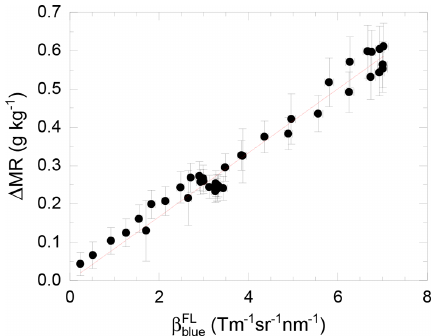
Figure 10. Relation between the magnitude of the water vapor mix- ing ratio correction ( (cid:49) MR) and the mean blue fluorescence spectral backscatter coefficient ( β FL ) as obtained for the RAMSES mea- blue surement on 9 August 2021 at 22:58UTC. For the fit a straight line through the origin was assumed, and the entire altitude range of the BBA layer was considered (3.6–6.1km). The fit yields for the gradient of the straight line m = ( 0 . 083 ± 0 . 001 ) m 2 sr and for the correlation coefficient (squared) r 2 = 0 .